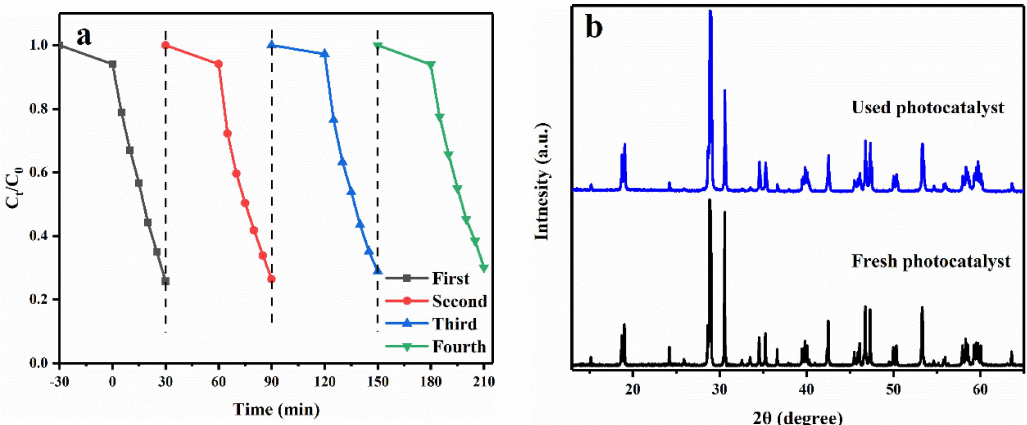
Figure 6. ( a ) Cyclic photocatalytic degradation of CIP in the presence of 0.3Bi-BVO (reaction volume: 100 mL, initial CIP concentration: 10 mg/L, catalyst dose: 0.1 g, and temperature: 20 ◦ C) and ( b ) XRD patterns of the used photocatalyst and fresh